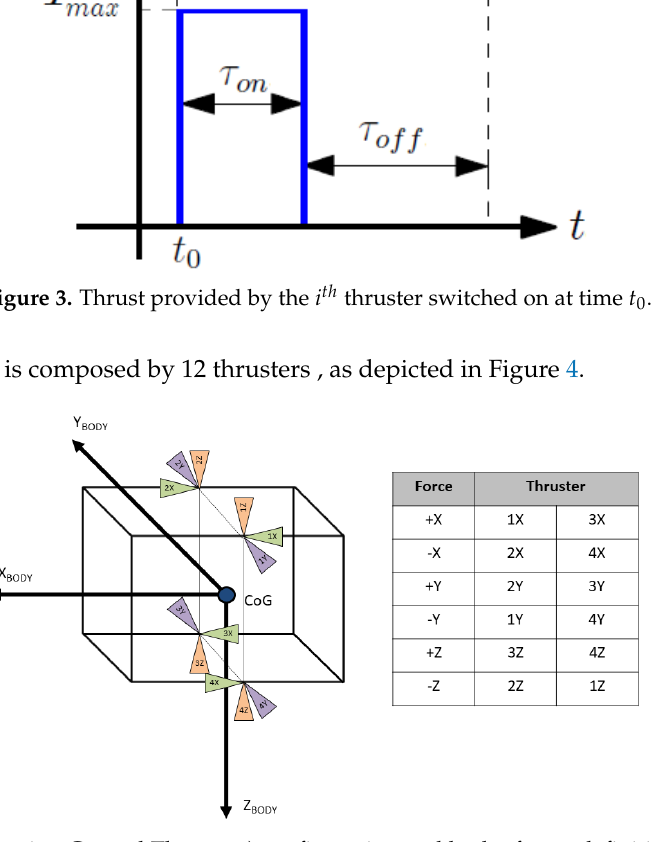
Figure 4. RCS (Reaction Control Thrusters) configuration and body frame definition. CoG: Center of